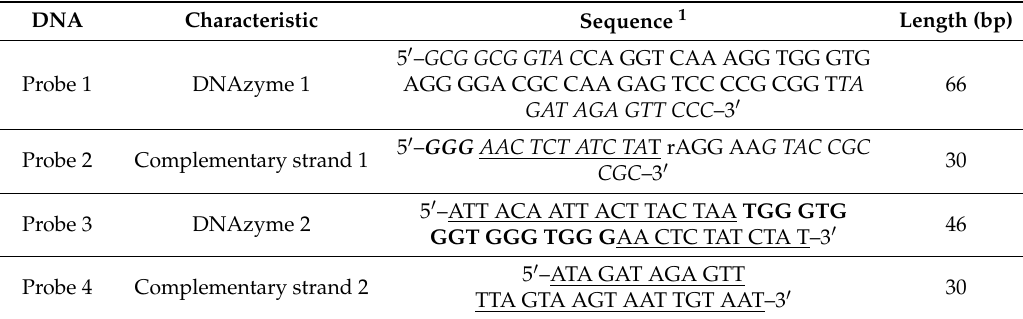
Table 1. List of oligonucleotides used in the present